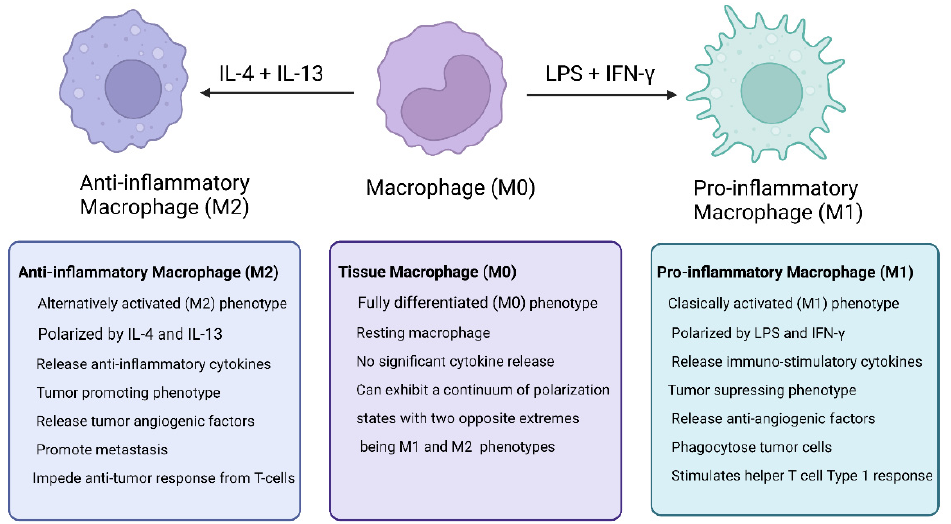
Figure 1. Comparative differences between M1 and M2 macrophages. Created with BioRender.com. Accessed on 21 April 2022.